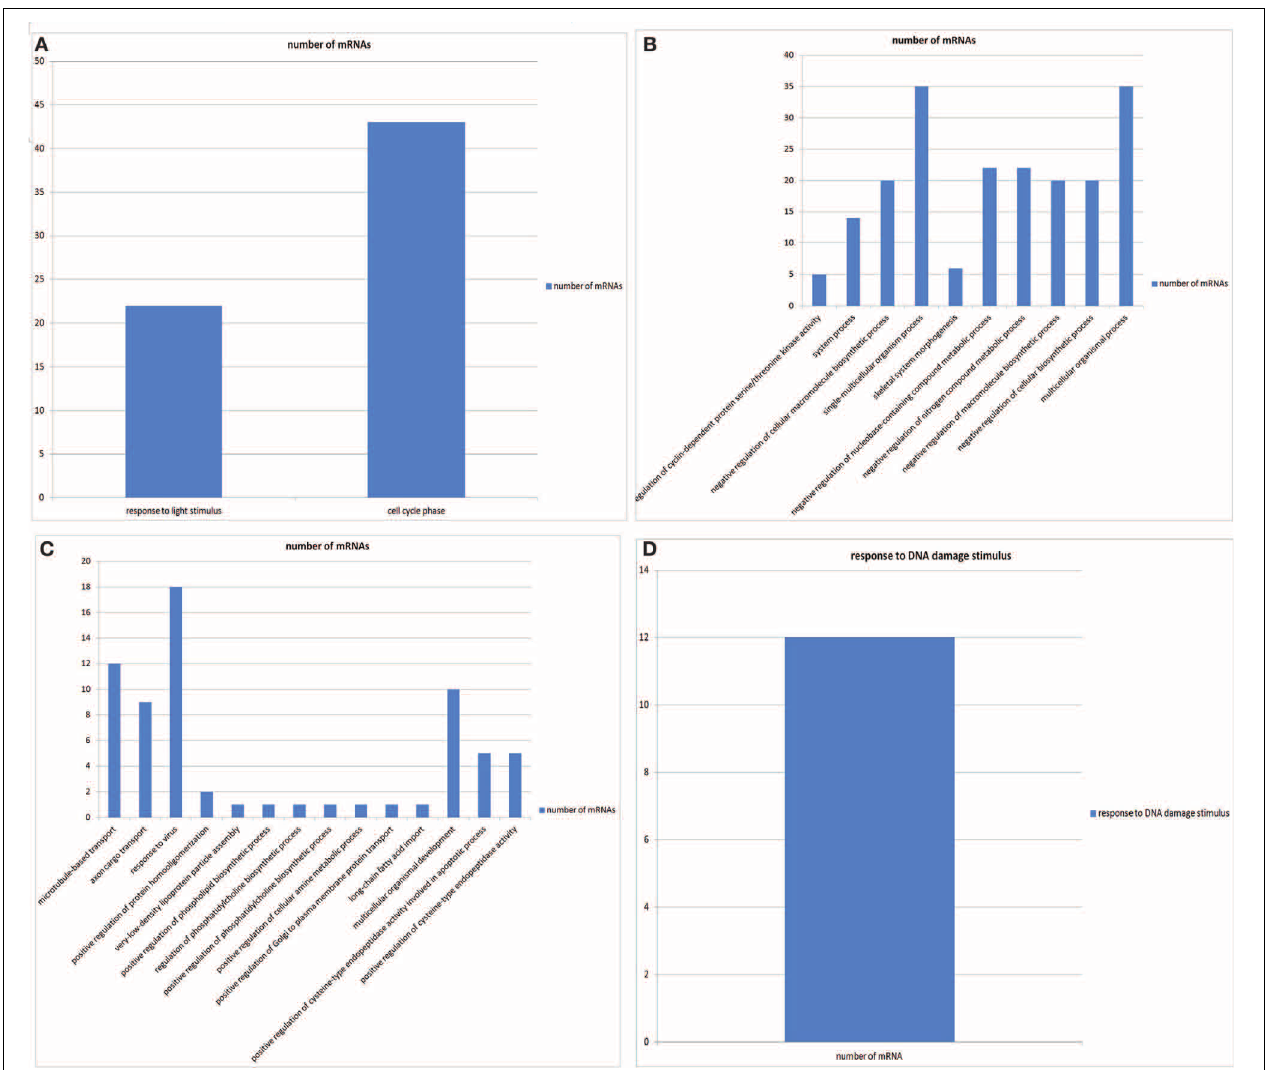
FIGURE 2 | (A) The GO enrichments of genes associated with breast cancer. (B) The GO enrichments of genes associated with cervical cancer. (C) The GO enrichments of genes associated with gastric cancer. (D) The GO enrichments of genes associated with oral